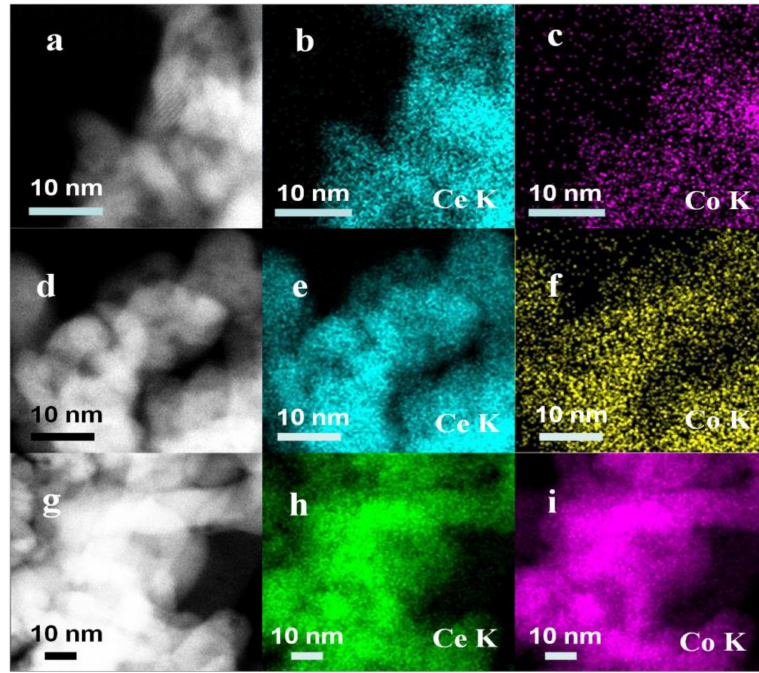
Figure 6. SEM elemental mapping for Co / CeO 2 -h( a – c ), Co / CeO 2 -p ( d – f ) and Co / CeO 2 -c( g – i